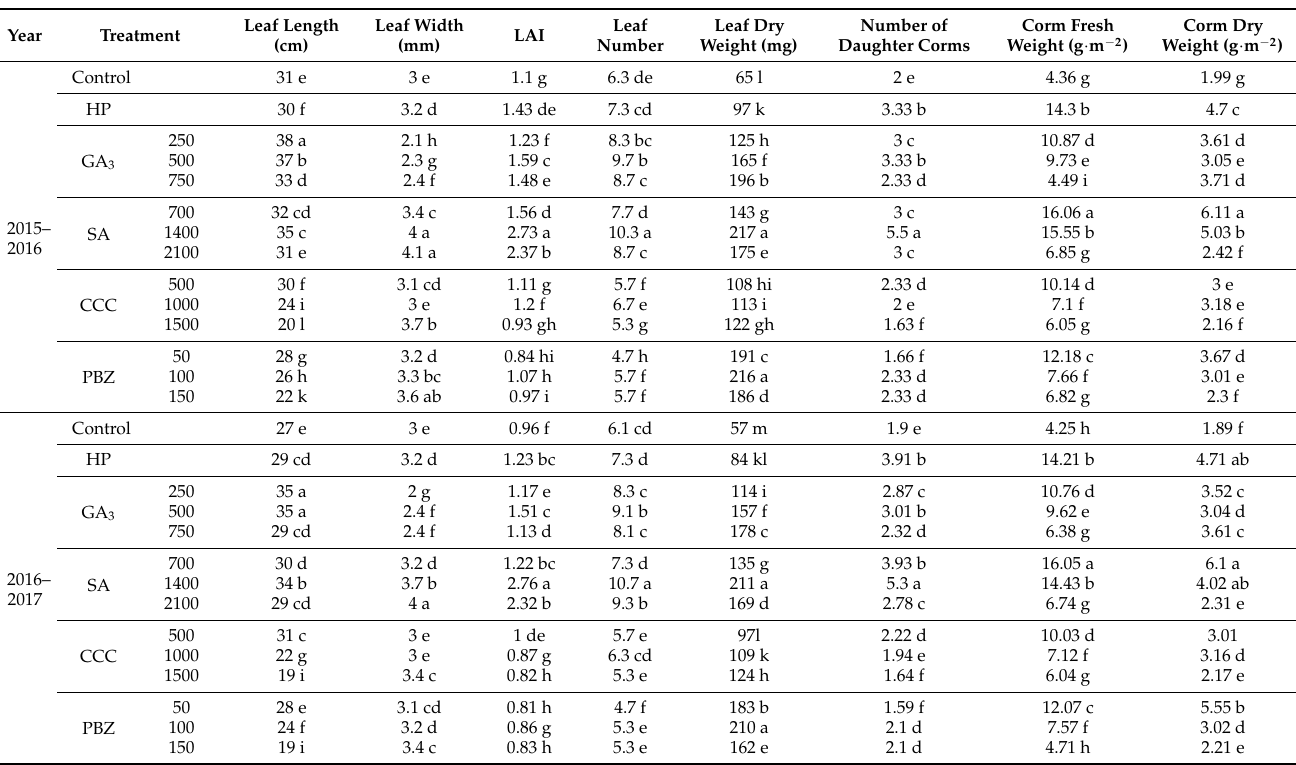
Table 3. Meancomparison of saffron vegetative traits primed with distilled water and different plant growth